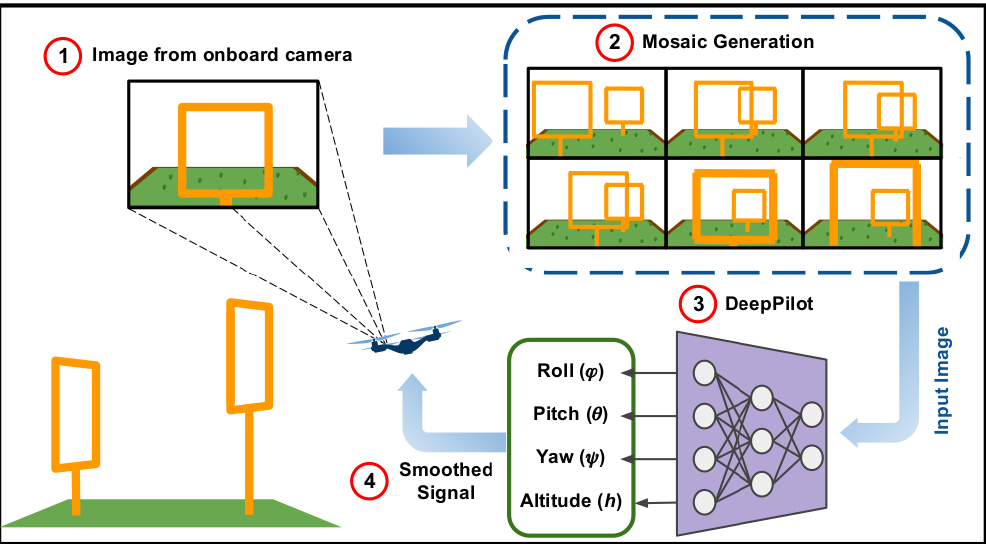
Figure 1. Overview of our approach, it consists of 4 steps: (1) Data acquisition using the drone’s onboard camera; (2) Real-time mosaic generation, consisting of 6 frames; (3) Flight commands